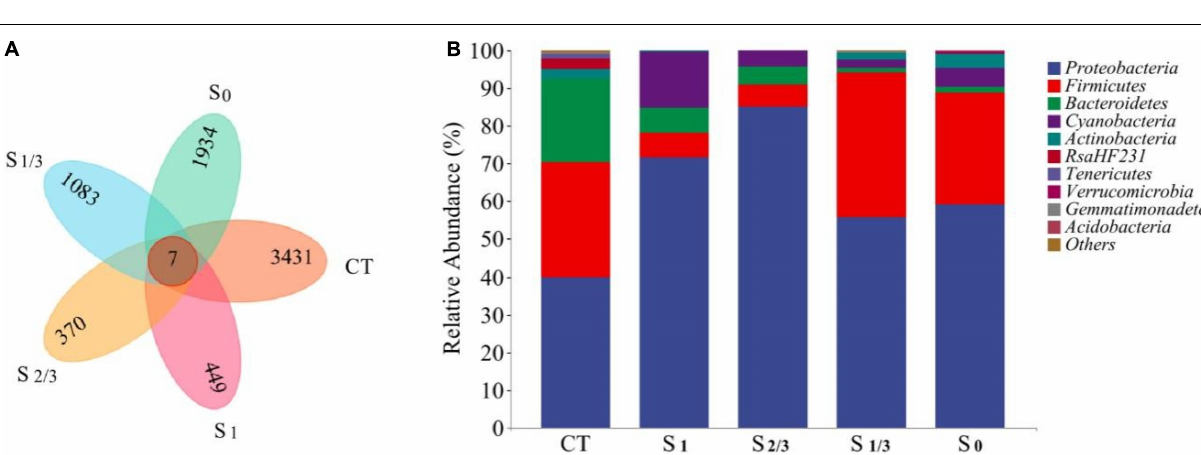
FIGURE 4 | Oxidative stress indexes of algae cells grown under different amounts of light: (A) ROS content, (B) and the concentration changes of superoxide dismutase (SOD), (C) peroxidase (POD), (D) malondialdehyde (MDA).